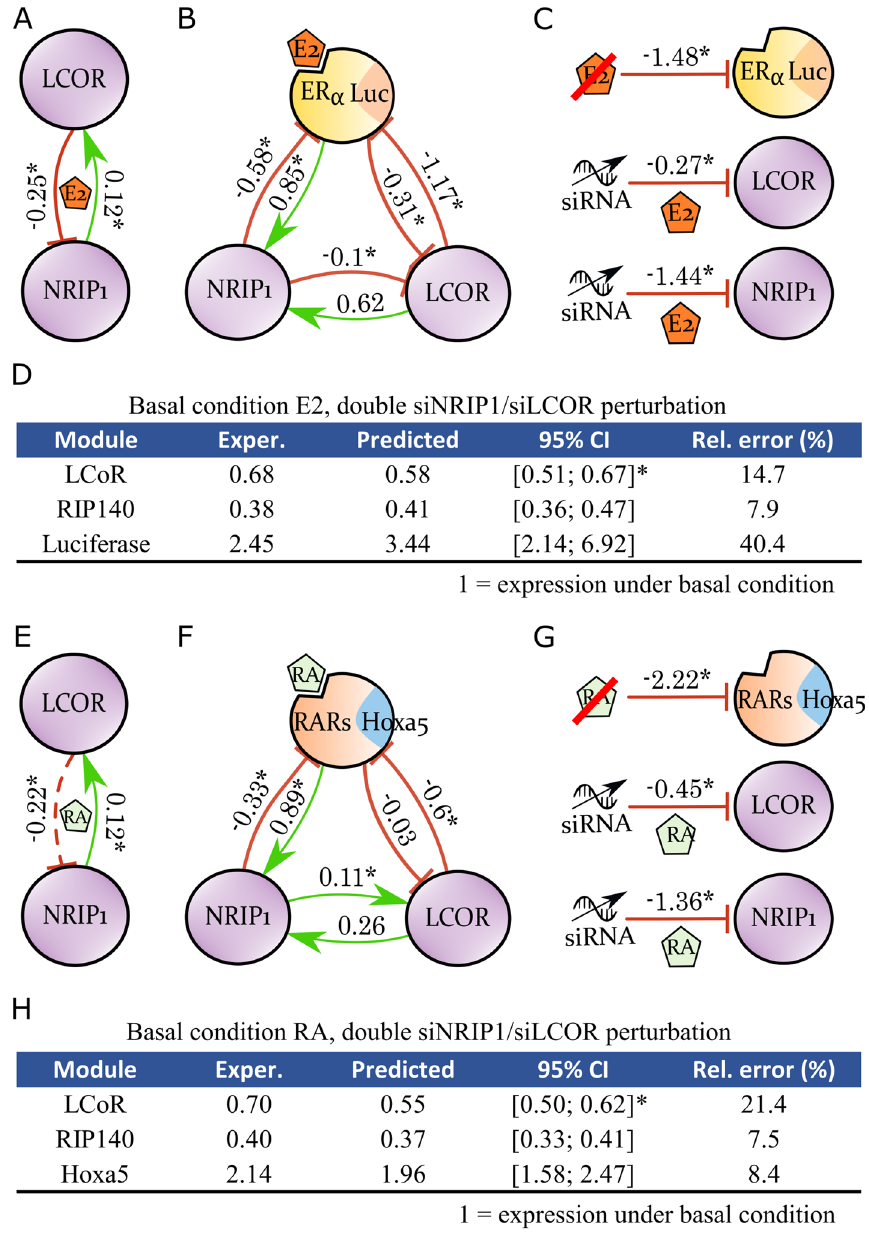
Figure 2. ER and RAR separated networks. ( A ) Connection coefficients between the two corepressors under the E2-stimulated condition. A 95% CI for each MRA parameter was estimated and the parameter denoted by an asterisk provided 0 was not included (sign known with 5% significance). ( B ) The ERα-NRIP1-LCoR transcriptional network. ( C ) ERα, NRIP1, and LCoR perturbation magnitudes. ( D ) Prediction of gene expression under dual siNRIP1 and siLCoR perturbation and E2 stimulation. *Note that LCoR experimental measure lies outside the 95% CI around the predicted value due to higher experimental data variability. A 96% CI equal to [0.45; 0.69] included LCoR experimental value. ( E ) Connection coefficients between the two corepressors under the RA-stimulated condition. ( F ) The RARs-NRIP1-LCoR transcriptional network. ( G ) RARs, NRIP1, and LCoR perturbation magnitudes. ( H ) Prediction of gene expression under dual siNRIP1 and siLCoR perturbation and RA stimulation. *LCoR 99% CI around the predicted value is equal to [0.50; 0.70], it includes LCoR experimental value. Figure created with Inkscape 0.92 (www. inksc ape. org) and R 3.6 (r-project.